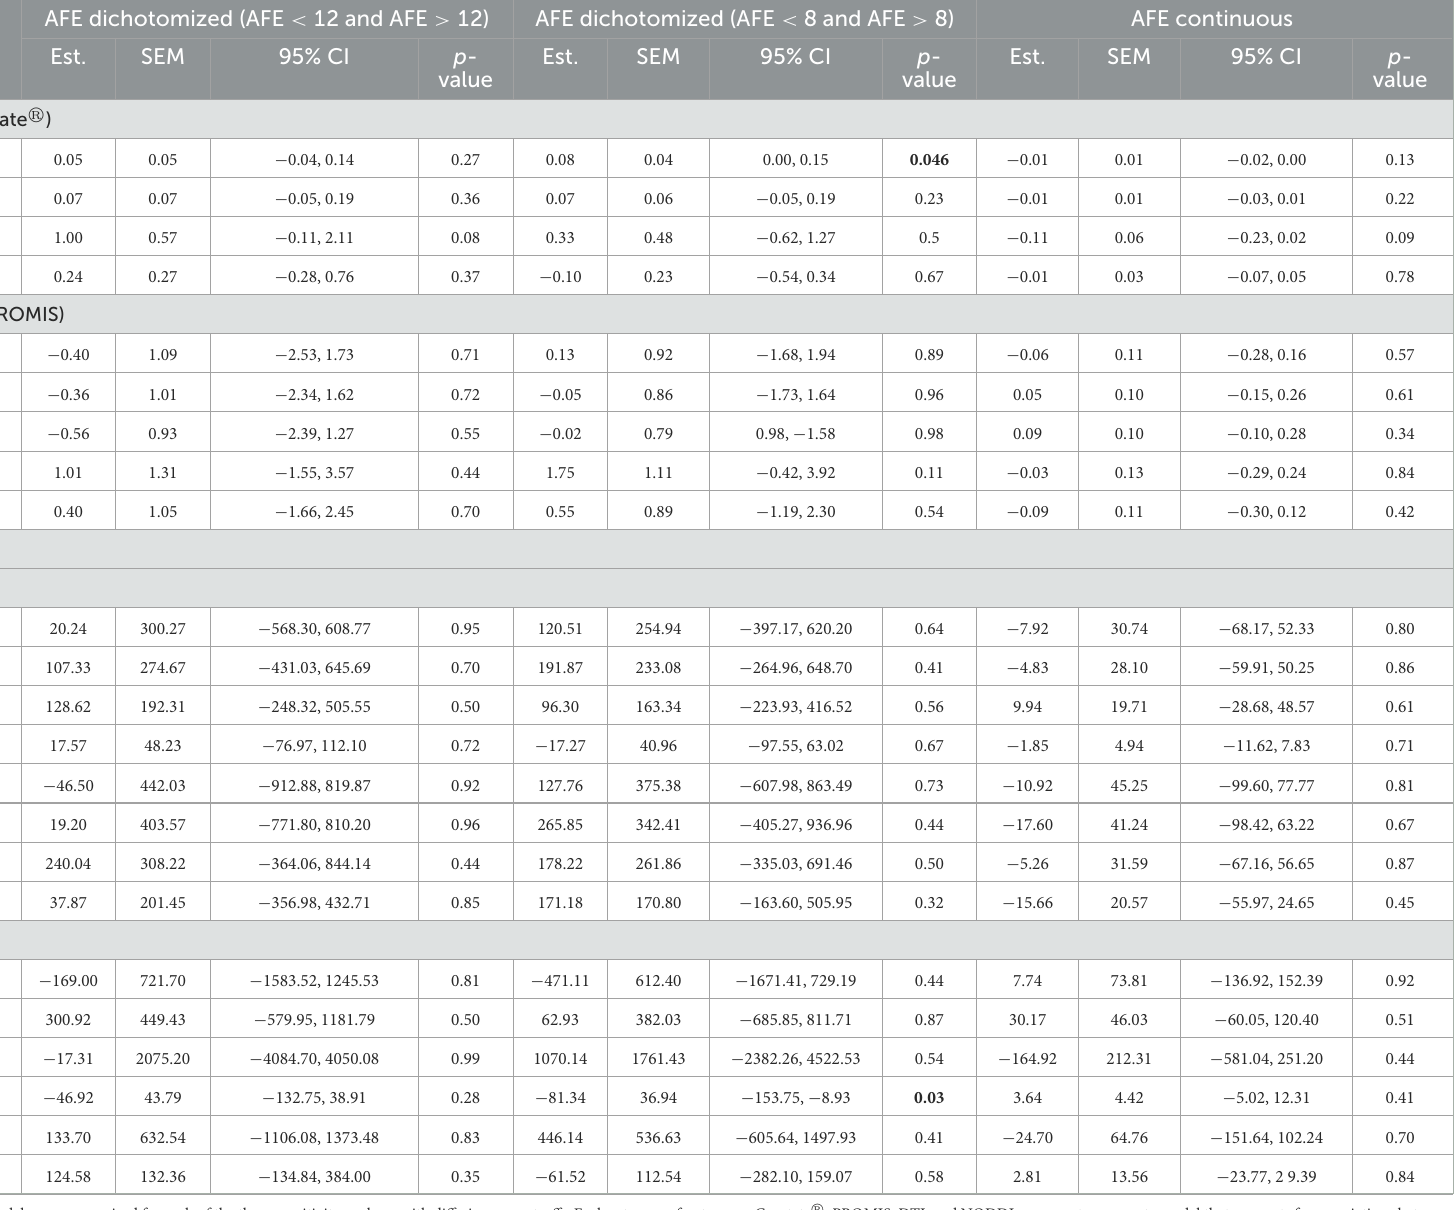
TABLE 3 Sensitivity